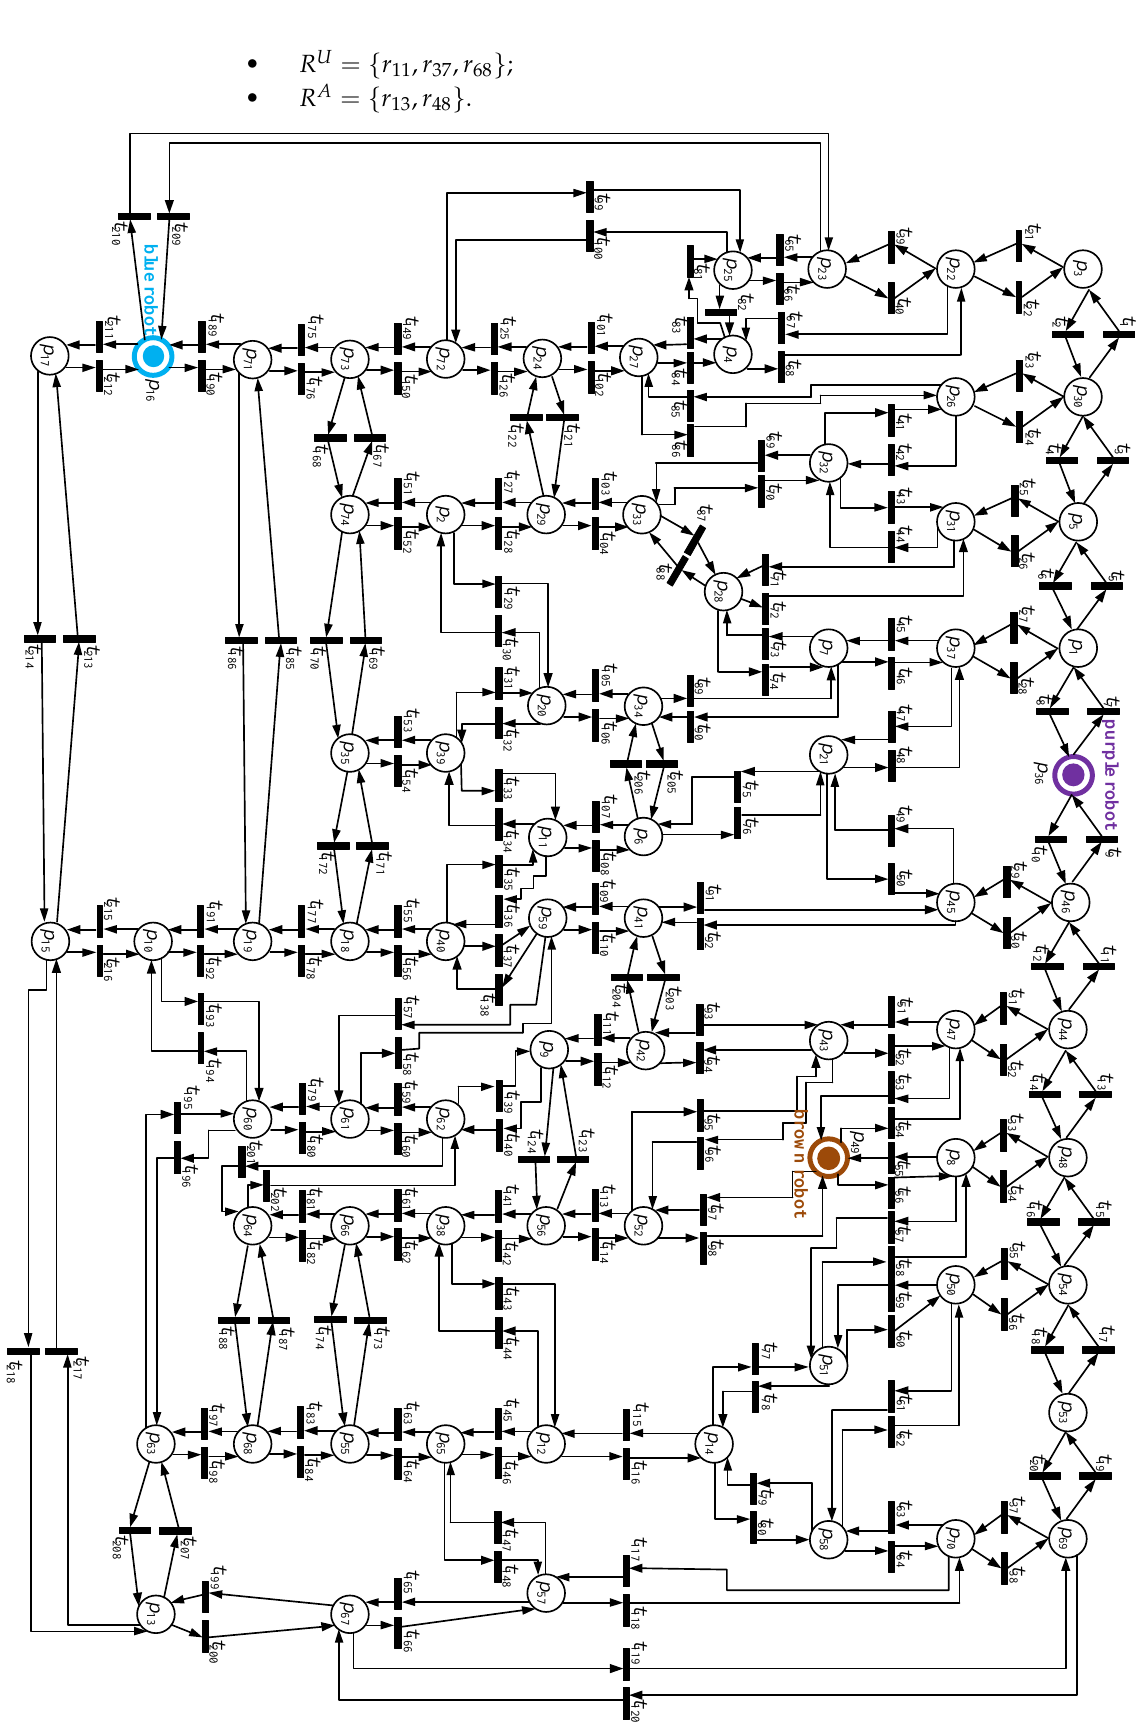
Figure 4. The TCPN system corresponding to the MTRS in Figure